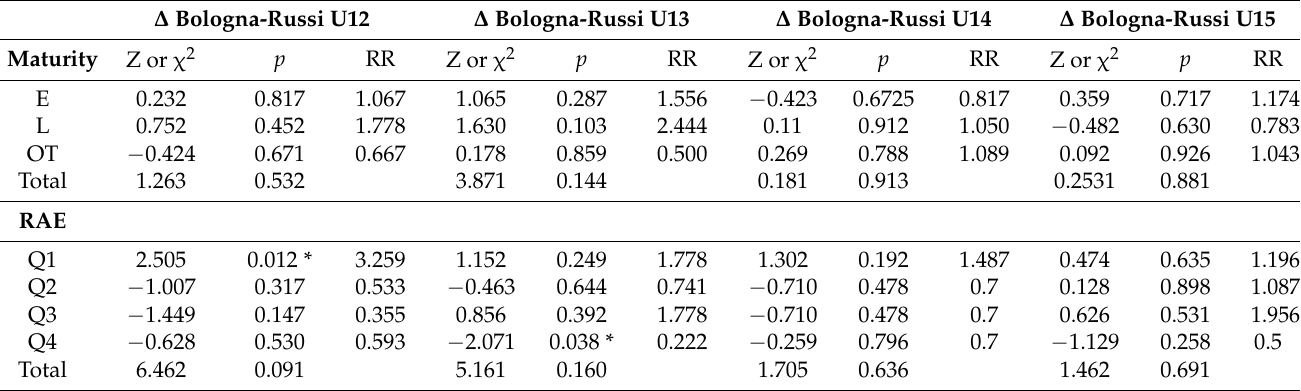
Table 1. Analysis of maturity and RAE proportions among categories of each football